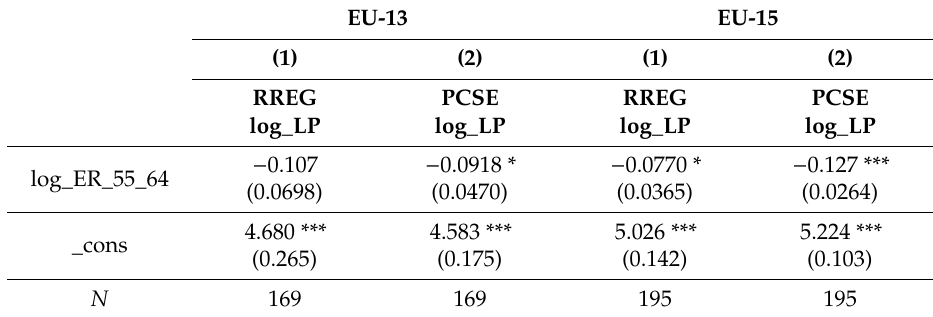
Table A7a. Results of macroeconometric models deployed for H 2 and H 3 , Robust regression (RREG), EU-13 and EU-15, 1995–2017.